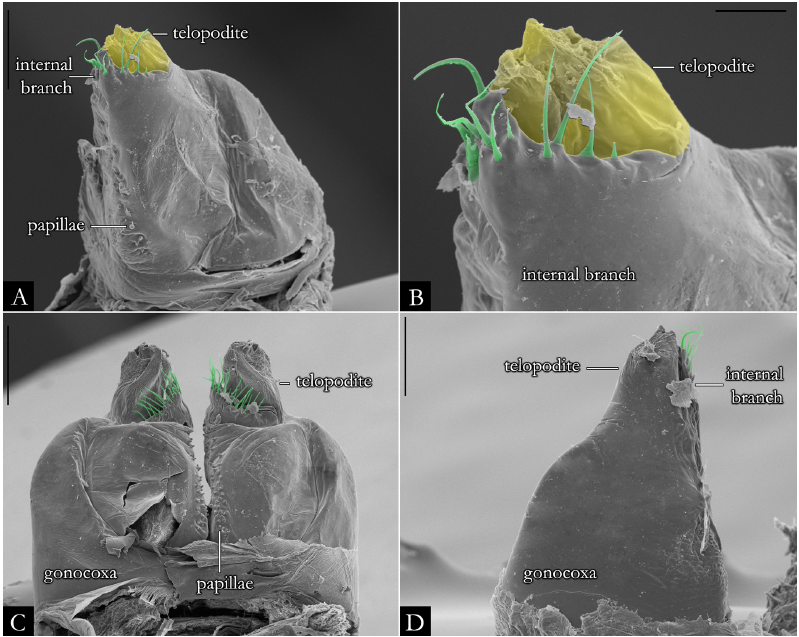
Fig. 34. Gonopod primordia in final stadia in Pseudonannolene microzoporus Mauriès, 1987 (IBSP). A–B . Left gonopod, in anal view. Setae on internal branch and telopodite highlighted in green and yellow, respectively. C . Gonopods, in anal view. D . Left gonopod, in oral view. Scale bars: A = 0.1 mm; B = 0.02 mm; C = 0.2 mm; D = 0.1